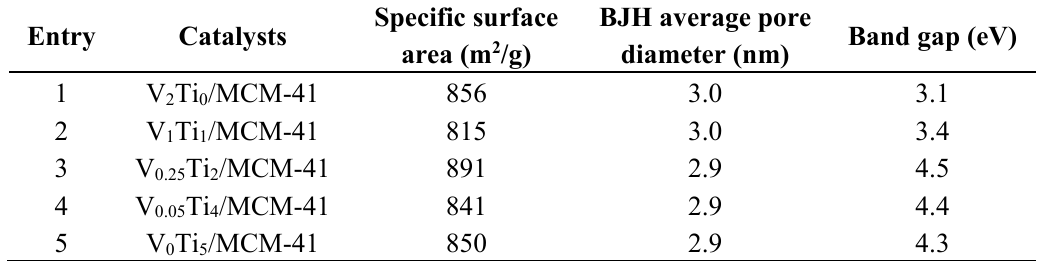
Table 2. Specific surface area, average pores diameter and band gap of series catalysts.